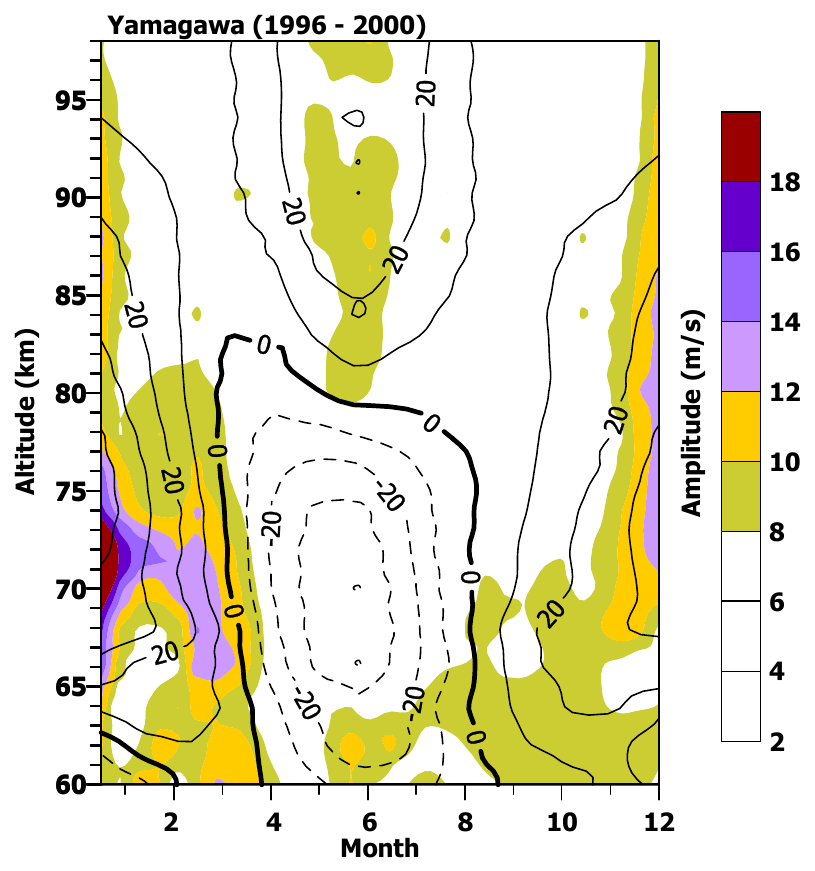
Fig. 6. Average climatology of the 16-day wave amplitudes (color scale) at Yamagawa for the five-year period 1996–2000. The solid (eastward winds) and dashed contours (westward winds) represent the mean zonal winds for the same